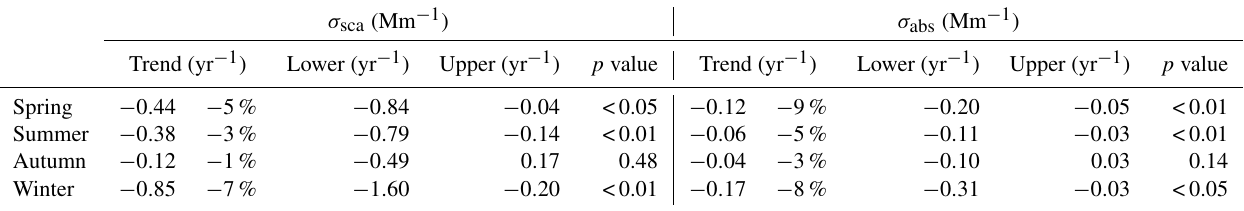
Table 4. Slopes of the seasonal trends and their statistical significance for σ sca and σ abs . The trend in the percentage was determined by comparing the slope of the trend with the seasonal median of the data.